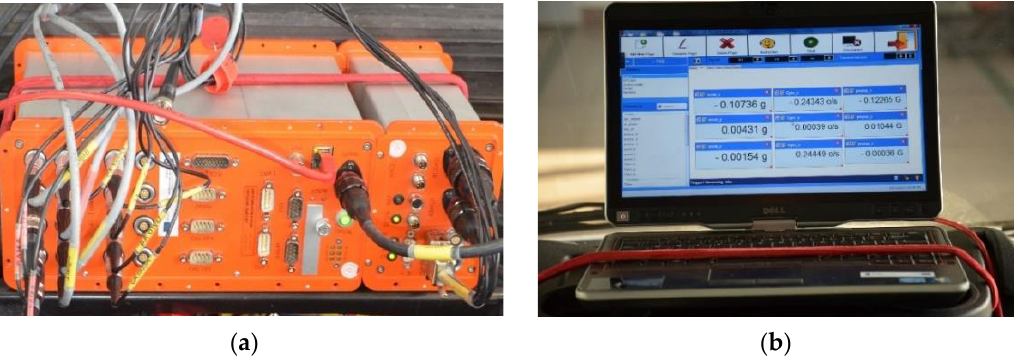
Figure 2. Data acquisition system: ( a ) uEEP 12 Data Acquisition Station Datron ® , ( b ) control tablet with ARMS ® software.